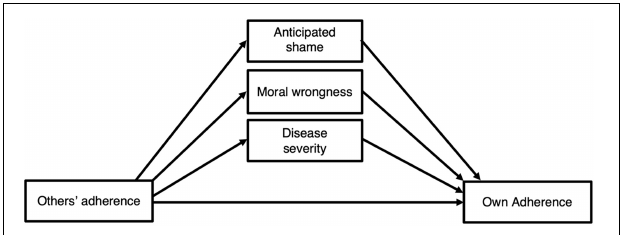
FIGURE 1 | Conceptual model illustrating possible pathways from perceived social norms to NPI adherence.